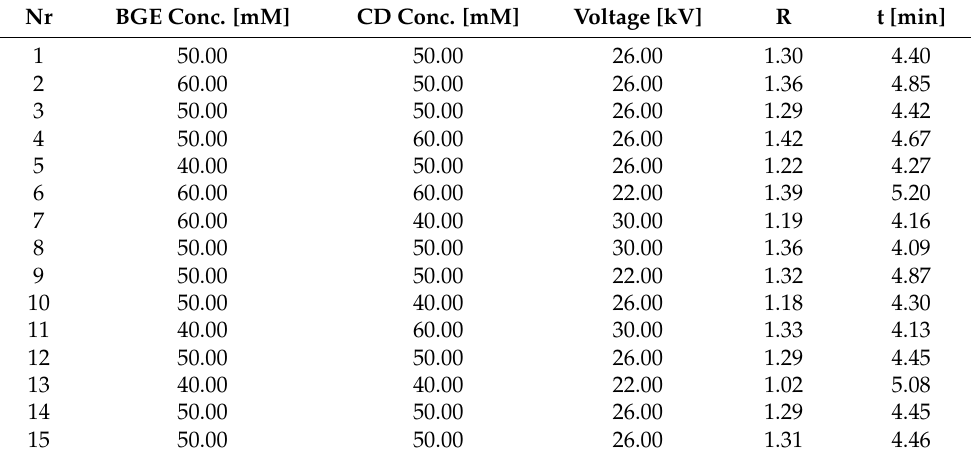
Table 2. Experimental plan and results obtained in the FCCD optimization